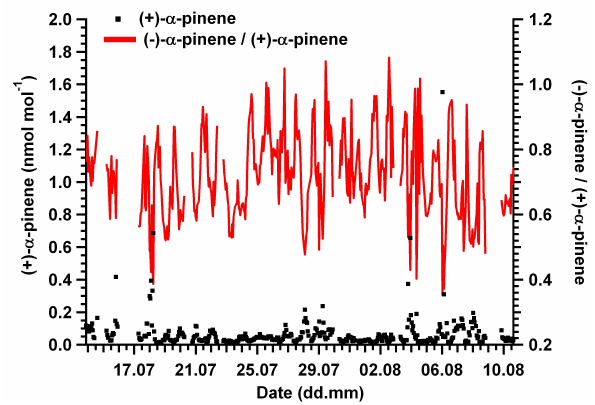
Fig. 8. (+)- α -pinene (black) and the ratio of ( − ) to (+)- α -pinene enantiomers (red) are shown. Measurements were made at the HUMPPA tower.